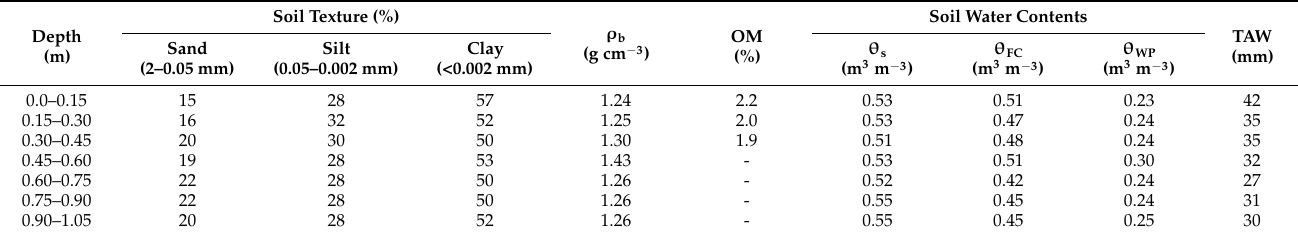
Table 2. Main soil physical and chemical properties of the experimental area.